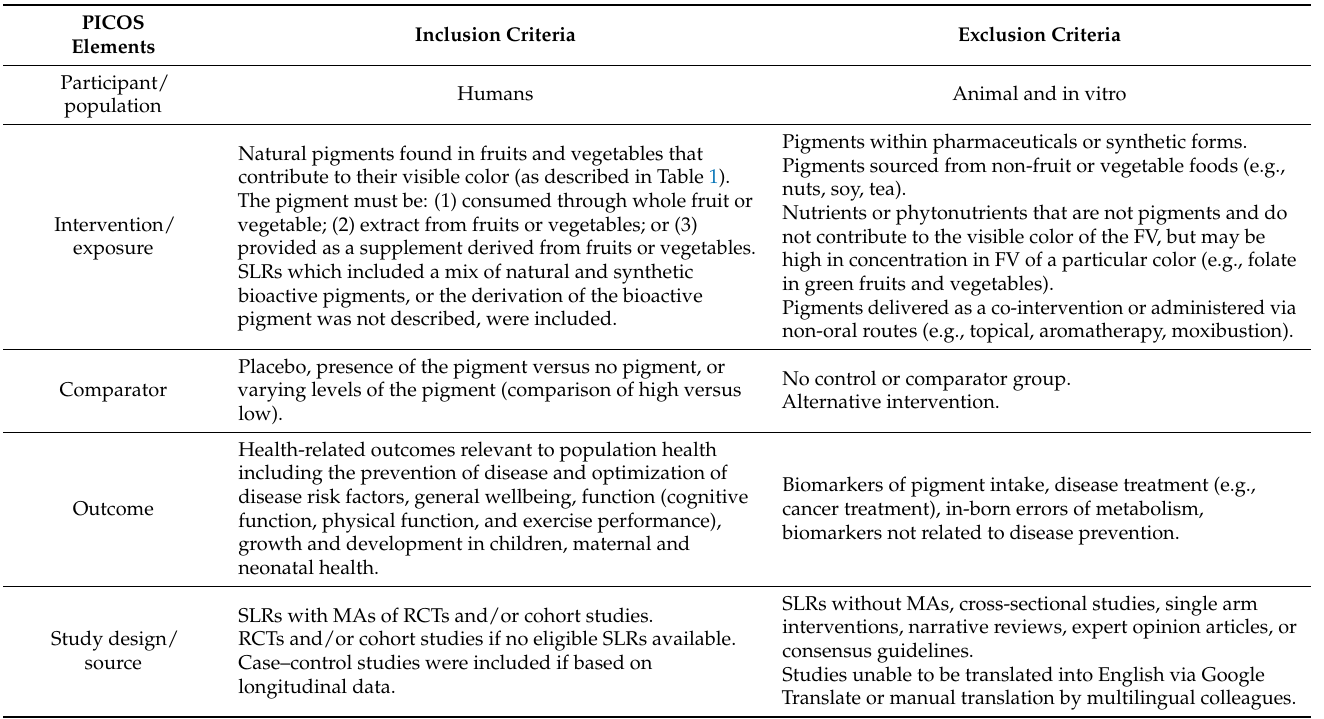
Table 3. PICOS Eligibility